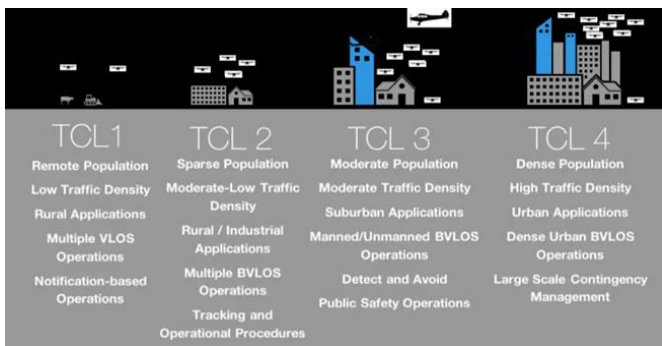
Figure 2. NASA UAS Traffic Management (UTM) Technical Capability Level (TCL) capabilities [15] (p. 11).